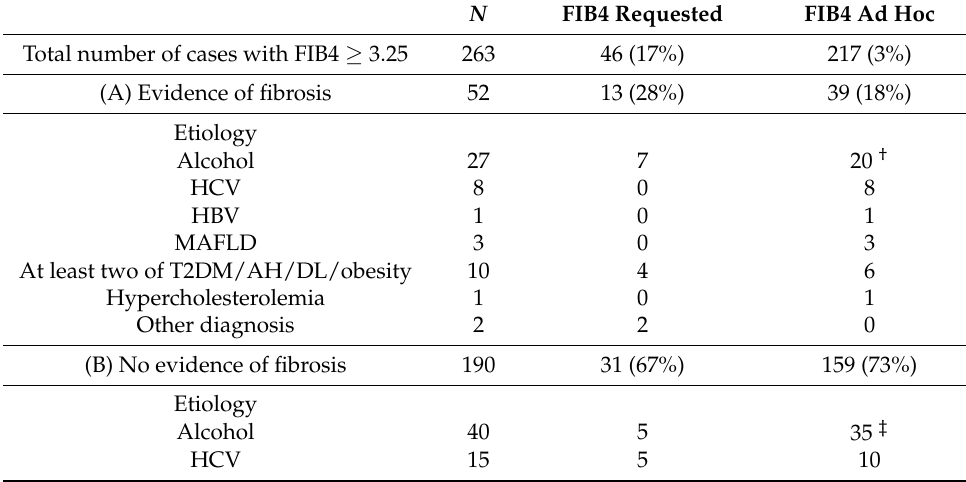
Table 3. Evidence of liver fibrosis in medical records of cases with FIB4 ≥ 3.25 according to FIB4 (requested or not) and its etiology. A: With evidence of fibrosis in the medical record (based on transient elastography, magnetic resonance, and/or sonography results). B: Without evidence of fibrosis in the medical record. C: No medical records